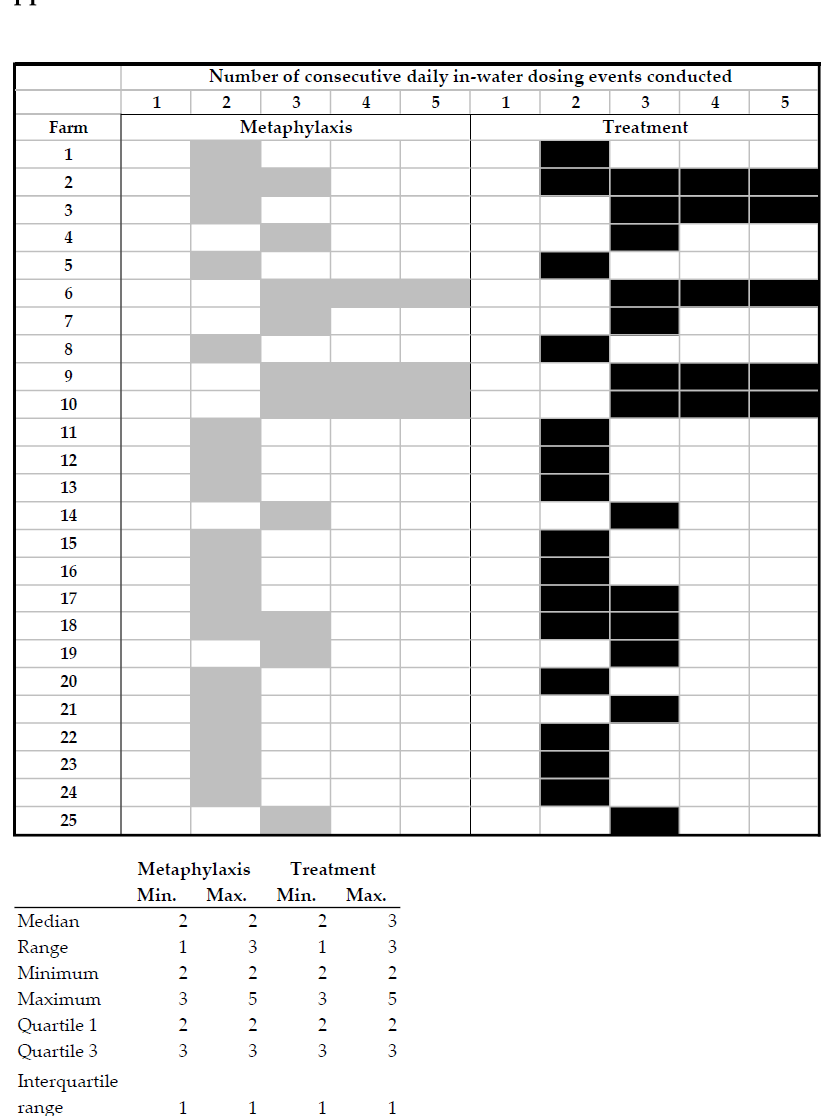
Figure A1. Summary and descriptive statistics for the number of consecutive daily in-water anti- biotic dosing events conducted for metaphylaxis and treatment of clinical disease on the 25 pig farms studied.